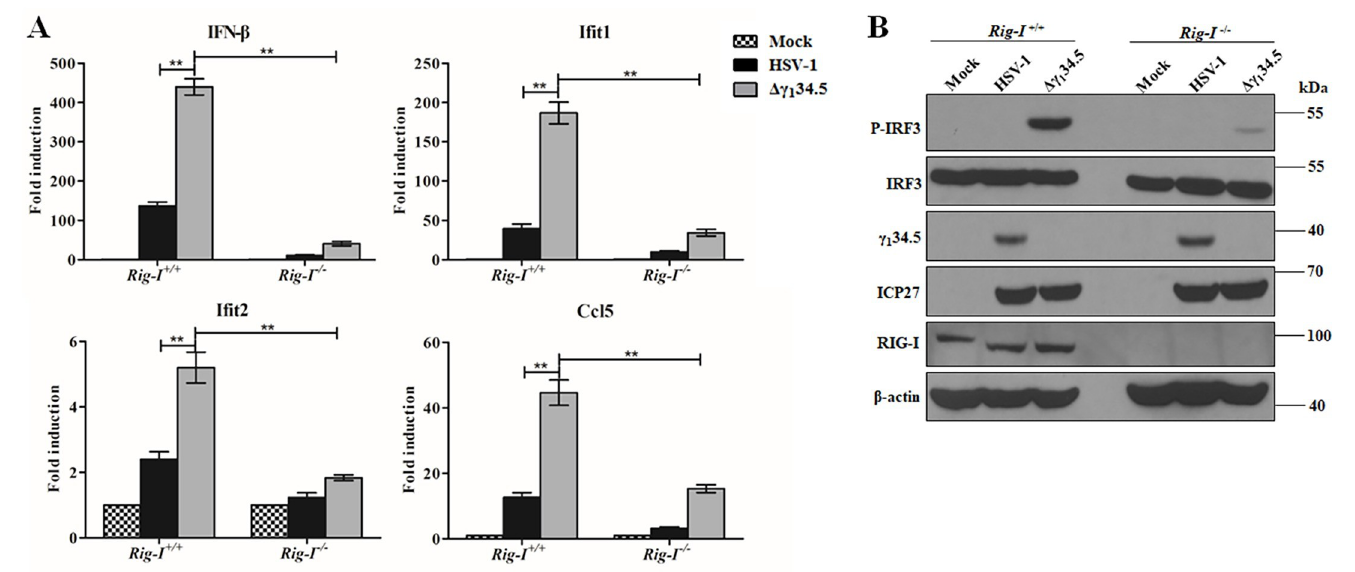
Fig 2. The γ 1 34.5 protein dampens antiviral responses mediated by RIG-I in MEF cells. (A) Effects of γ 1 34.5 on antiviral gene expression. Rig-I +/+ or Rig-I -/- MEF cells were infected with wild type HSV-1 or Δγ 1 34.5 (5 pfu/cell). At 8 h after infection, RNA transcript levels of IFN- β , Ifit1, Ifit2, and Ccl5 were assessed by quantitative PCR analysis. The results were expressed as fold activation relative to 18S ribosomal RNA, with standard deviations among triplicate samples. The data were statistically analyzed by one-way ANOVA ( �� , P < 0.01). (B) Effects of γ 1 34.5 on IRF3 phosphorylation. Rig-I +/+ or Rig-I -/- MEF cells were mock infected or infected with the indicated viruses (5 pfu/cell). At 8 h postinfection, cell lysates were processed for western blot analysis with antibodies against p-IRF3, IRF3, ICP27, γ 1 34.5, RIG-I, and β -actin. The experimental data are representative of results from three independent experiments.